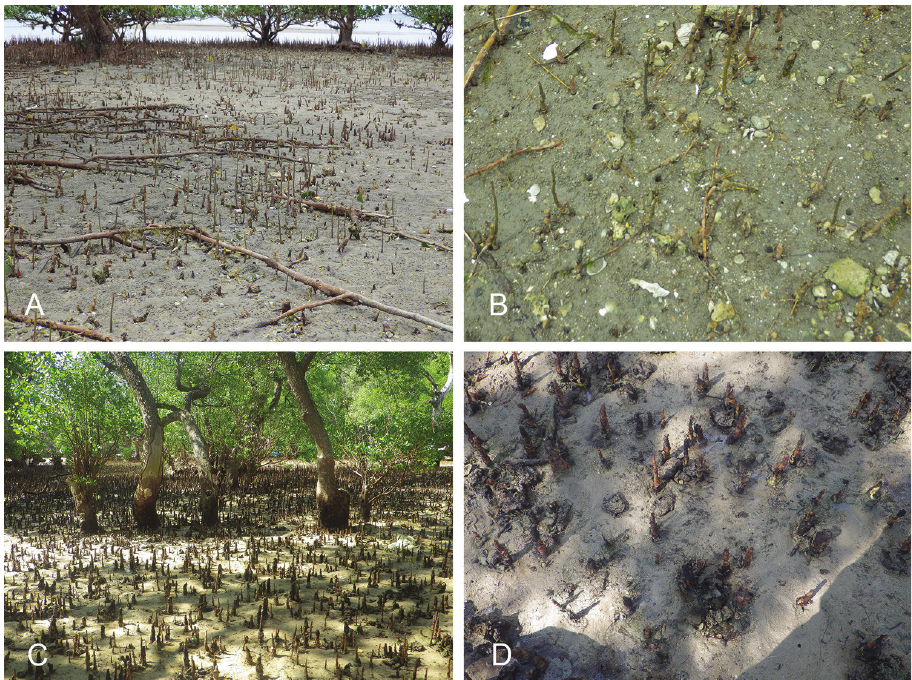
Figure 43. Habitats, Wallaconchis graniferum . A Philippines, Bohol, Loay, mostly sand, very few rocks, and a few small Avicennia trees (st 198) B Close up of sand with shells and Avicennia roots (same locality as A) C Indonesia, Timor, Oesapa, sandy area of mangrove with Avicennia and Sonneratia trees spread out D Close up of sediment and onchidiid tracks (same locality as